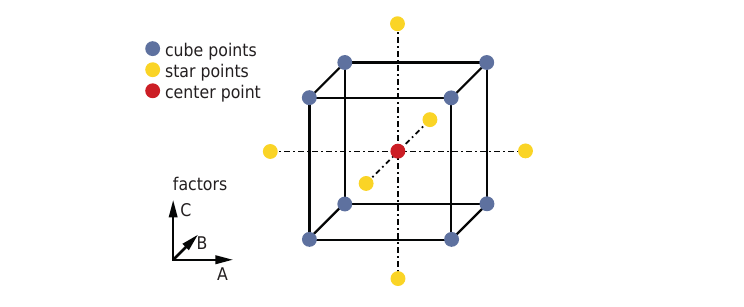
Figure 1. Schema of a central composite design with three factors, A, B and C. It consists of a full factorial design (cube points), which is extended by a center point and star